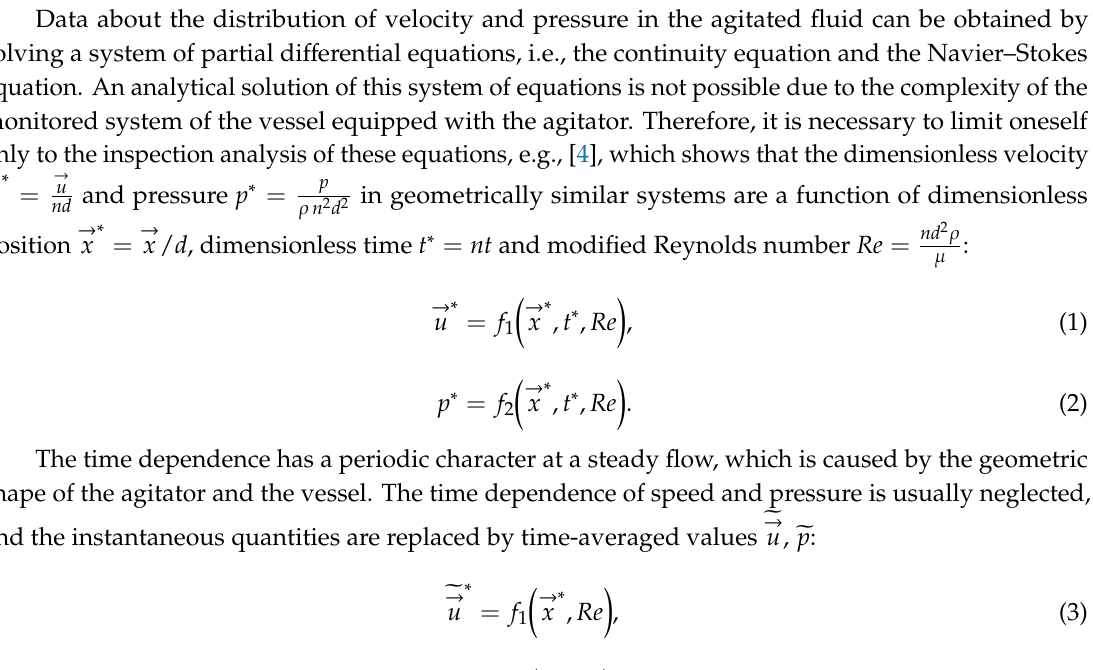
Figure 2. Flow in a vessel with a rectangular cross-section equipped with an axial impeller.